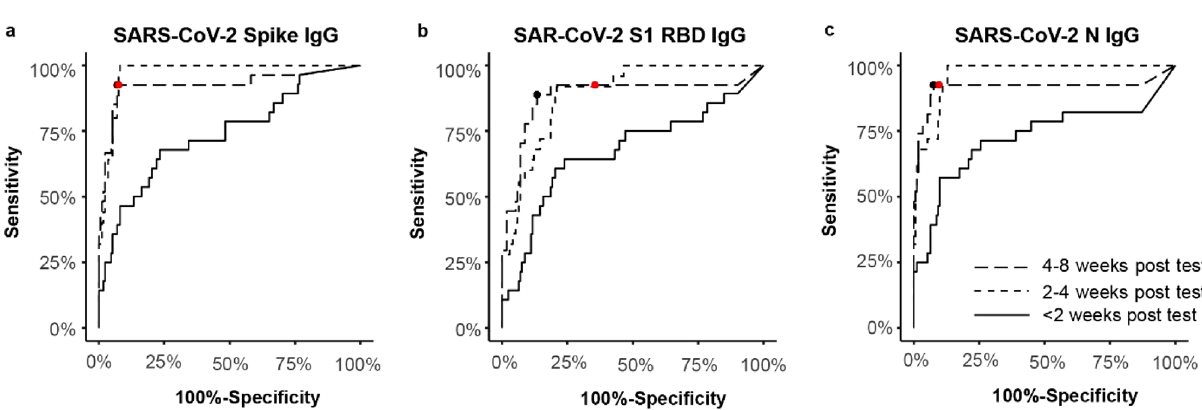
Figure 3. Receiver-operator characteristic (ROC) curves for classifying SARS-CoV-2 PCR results based on salivary anti-SARS-CoV-2 IgG antibodies. Curves are drawn to show performance of assay at < 2 weeks, 2–4 weeks, and 4–8 weeks after a PCR test. The red dot indicates sensitivity and specificity achieved at the 4–8 week time point for the pre-established threshold. The black dot indicates, on the same curve, the threshold that maximizes sum of sensitivity and